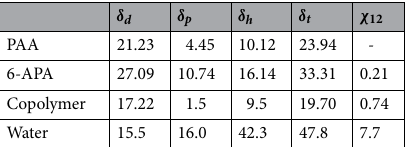
Table 6. Hansen solubility parameters and χ 12 values for all compounds at 298